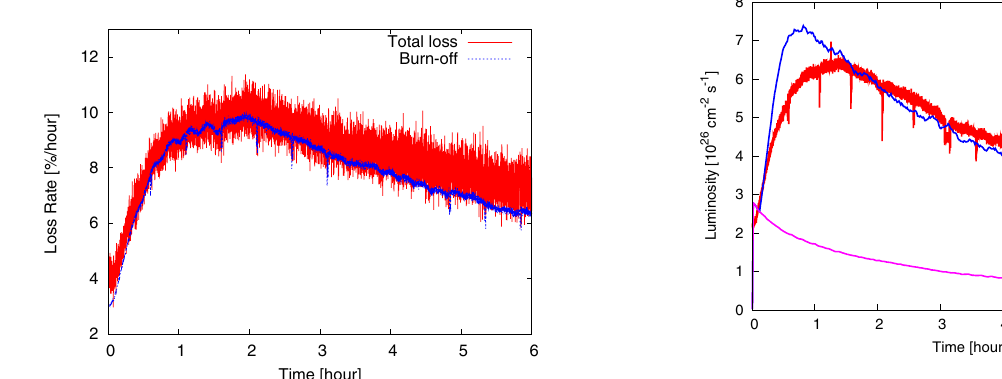
FIG. 12. Comparison of luminosities from simulation ( “ sim ” ) and from IP8 ZDCs ( “ PHENIX ” ) for the 2012 RHIC 96.4 GeV U-U run. The simulated luminosity without cooling ( “ sim, no cooling ” ) is also